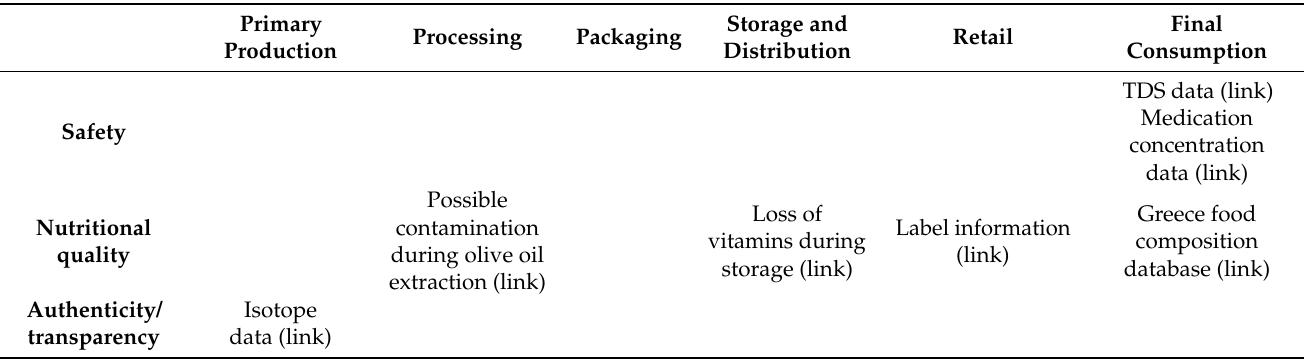
Table 3. Example of result presentation of a 2-dimensional space